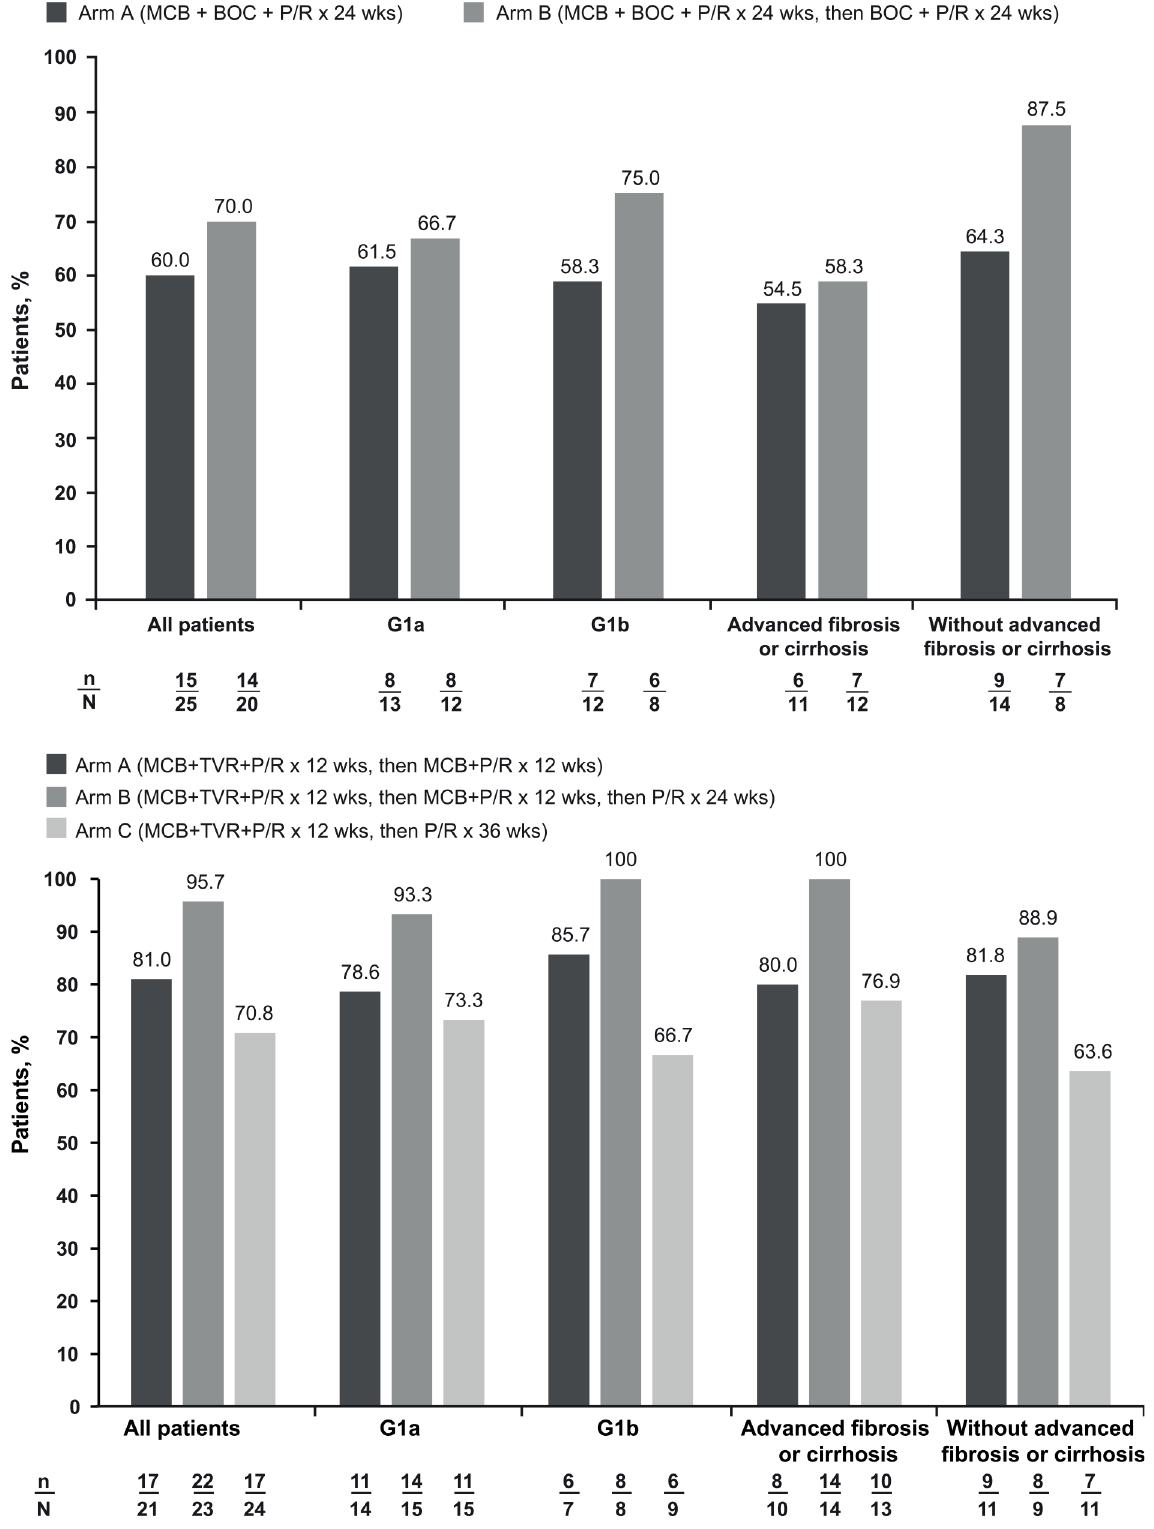
Fig 4. SVR12 rates by treatment arm in the overall populations and by HCV genotype and presence/absence of bridging fibrosis or cirrhosis in DYNAMO 1 (a) and DYNAMO 2 (b). BOC, boceprevir; MCB, mericitabine; P/R, peginterferon alfa-2a + ribavirin; TVR, telaprevir.